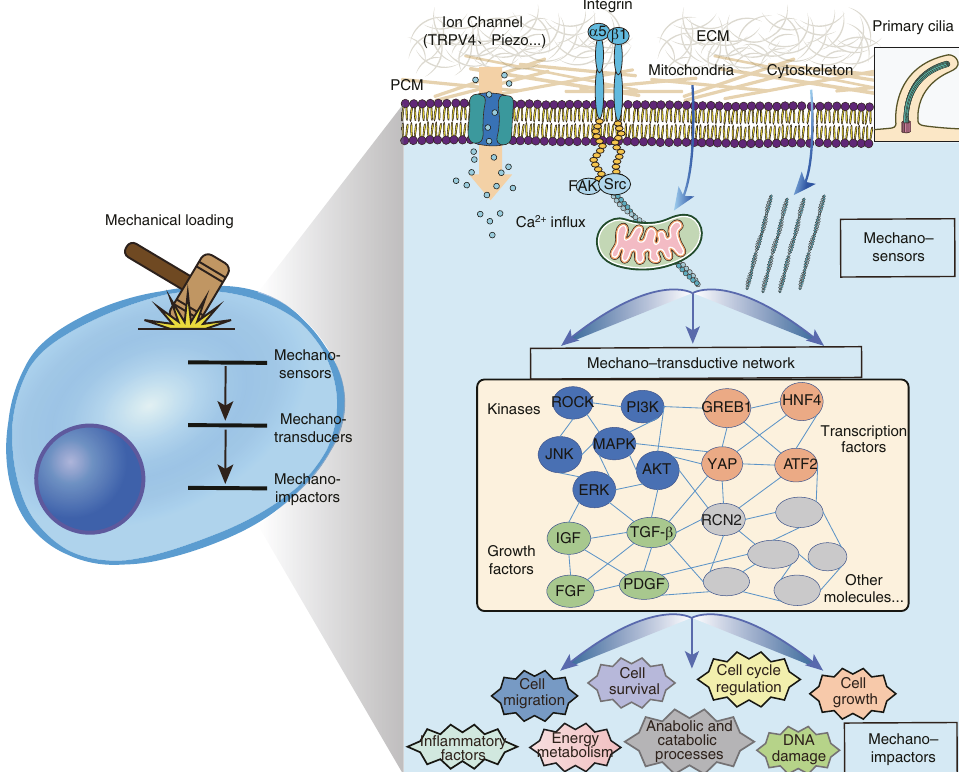
Fig. 1 The three-tiered cascade of mechanotransduction pathways in cells. The fi rst structures in fl uenced by mechanical stimulation are different types of mechanosensors, including pericellular matrix (PCM) and extracellular matrix (ECM) components, mechanically gated ion channels and porins (such as TRPV4 and Piezo), integrins, mitochondria, cytoskeleton, and primary cilia. Mechanotransducers include multiple types of factors, such as kinases (ROCK, PI3K-AKT, MAPK, etc.), growth factors (IGF, TGF- β , etc.), transcription factors (YAP, GREB1, etc.), secretory proteins (RCN2, etc.), and other molecules, which are activated by mechanosensors and then alter speci fi c downstream molecules. Mechanoimpactors are the fi nal outputs of mechanical stimulation and cause changes in cell phenotypes and behaviors, such as cell migration, survival, growth, energy metabolism, and in fl